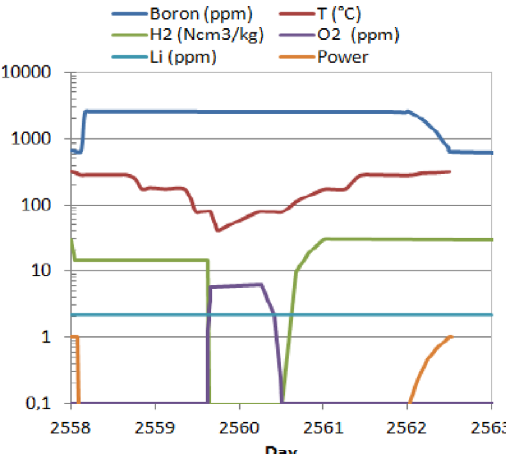
Fig. 3. Operating data used for the simulation of the mid-cycle shutdown and restart.